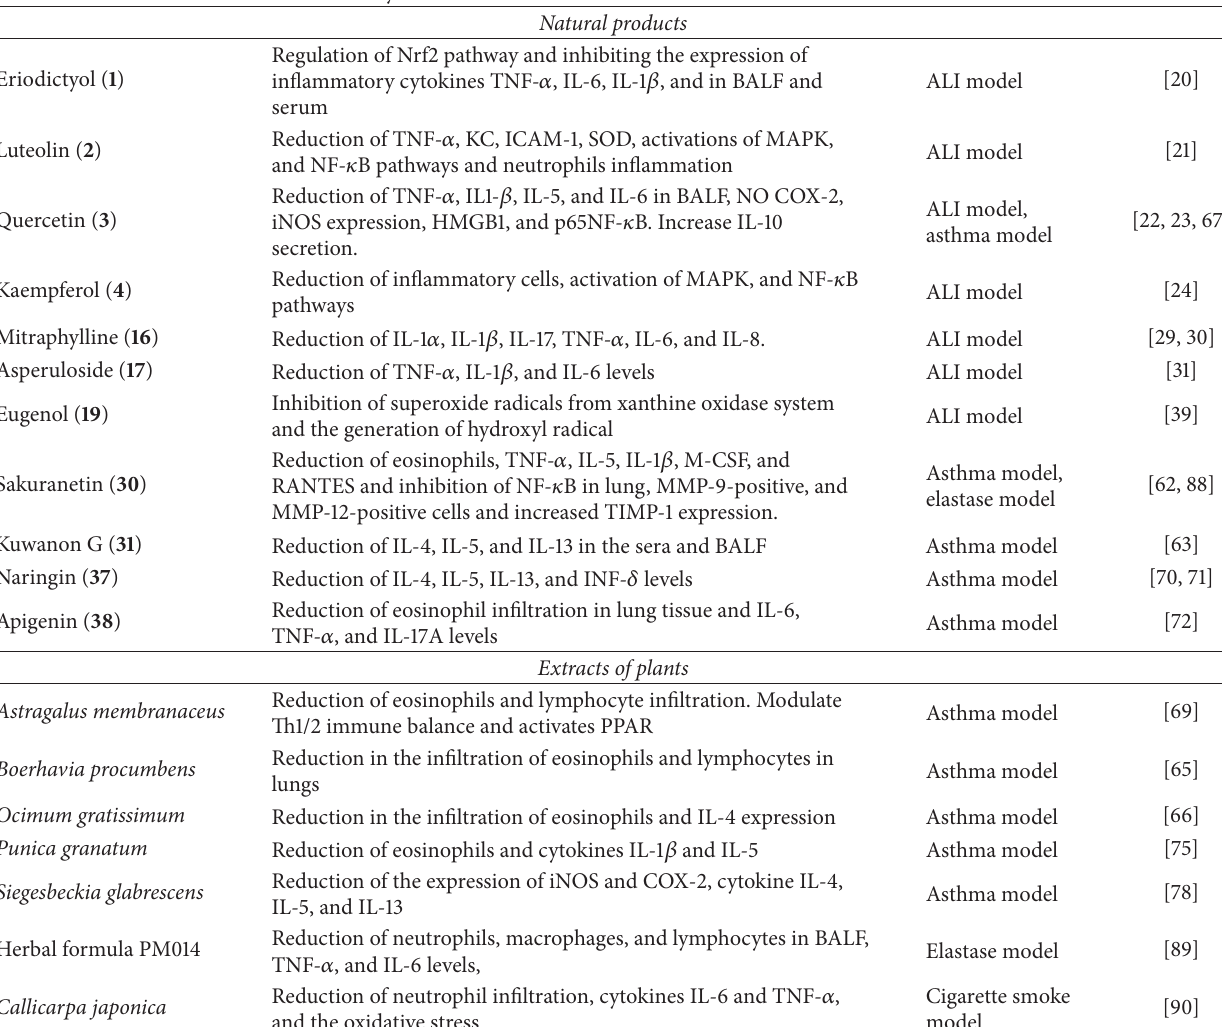
Table 1: Herbal-derived natural compounds effects in lung inflammation and